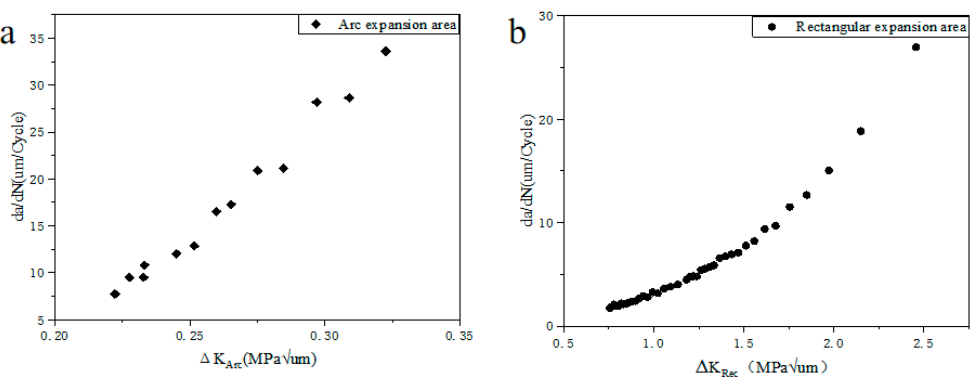
Figure 14 . Crack growth rate curve (( a ) arc expansion area and ( b ) rectangular expansion area).